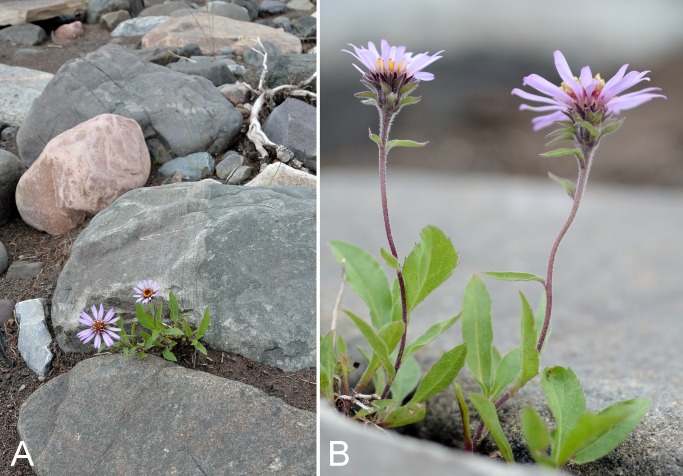
Eurybia sibirica.(A) Habitat, Saarela et al. 4113a. (B) Habit, Saarela et al. 4113a. Photographs by R. D. Bull.